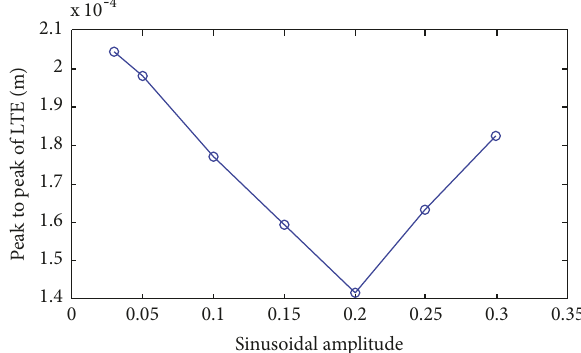
Figure 12: Peak-to-peak value of LTE under different amplitudes of sine load